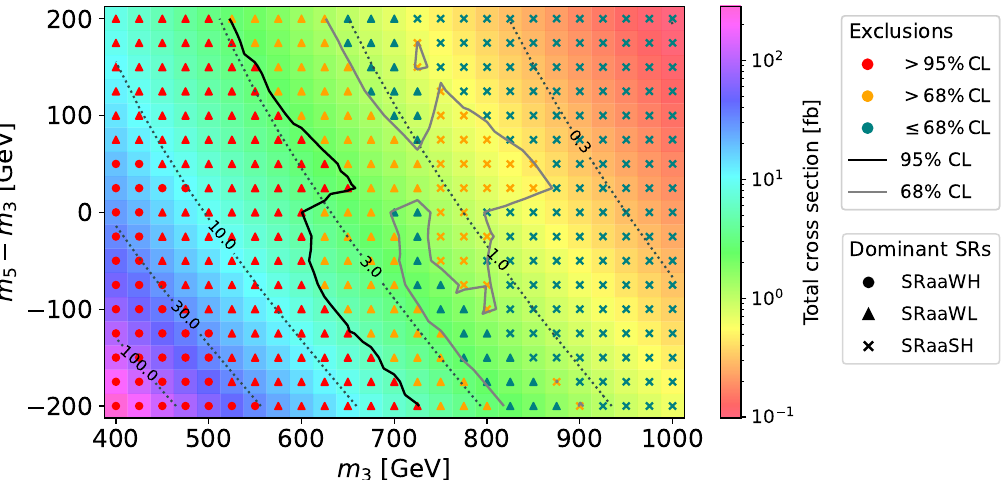
Figure 10. Bounds on the pNGB masses for the Drell-Yan production of the custodial triplet η 3 and quintuplet η with the singlet η decoupled (scenario S-35). Depending on the mass hierarchy, 5 1 the pNGBs decay either into di-bosons or into one vector boson and a lighter pNGB. The heatmap and the dotted contours show the sum over all scalar pair production cross sections. The bounds are obtained from ref. [70], with the dominant signal region indicated by the marker symbol (see appendix A.3 for details.). The 95% and 68% CL exclusion contours are drawn in solid black and grey,